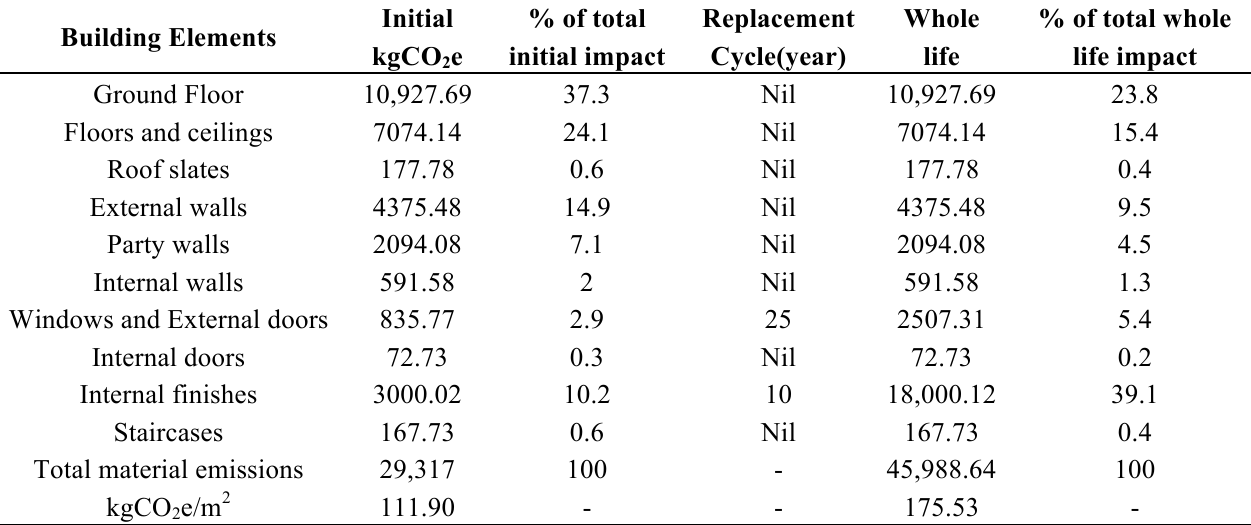
Table 6. Breakdown of CO e emissions of building elements of the refurbished housing 2 development at Cross Street (all three new housing